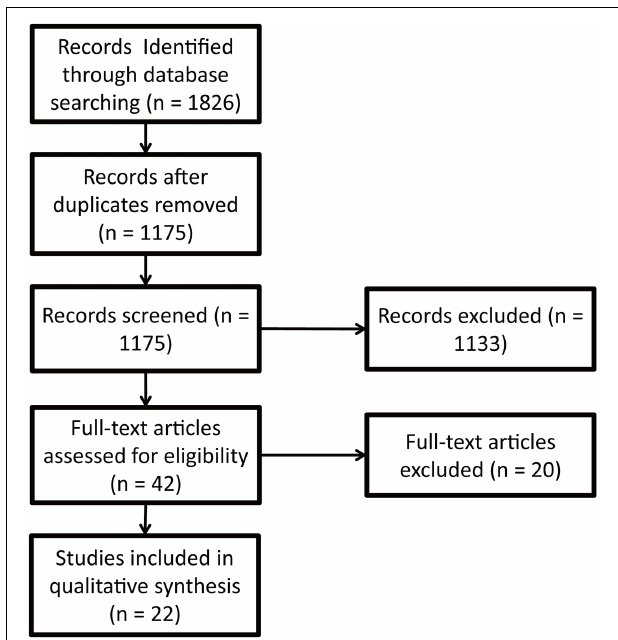
FIGURE 1 | The procedure of study identification and